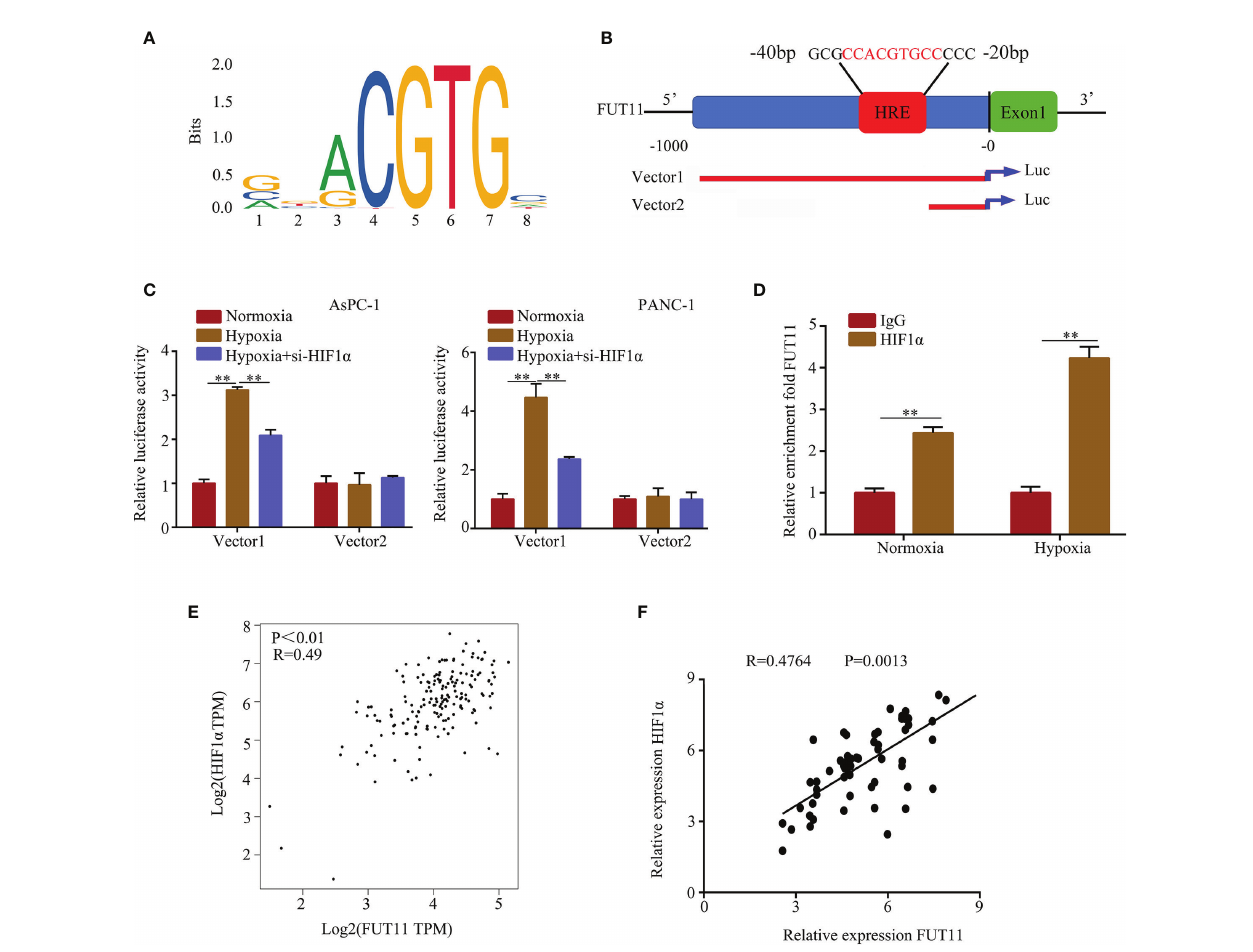
FIGURE 7 | HIF1 a regulates the expression of FUT11 by binding to the HRE of the FUT11 promoter. (A) The motif of HIF1 a . (B) The hypoxia response element (HRE) in the promoter of FUT11 (Vector 1: vector with full-length FUT11 promoter; Vector 2: vector with truncated FUT11 promoter which lack of HRE). (C) PANC ‐ 1 and AsPC-1 cells transfected with either a full ‐ length or truncated FUT11 promoter ‐ pGL3 reporter vector and cultured under hypoxia, with or without si ‐ HIF1 a . After 48 hours, luciferase activity was measured using the dual ‐ luciferase reporter assay system. (D) ChIP assays with anti-HIF1 a antibody verifying the binding between HIF1 a and hypoxia response element of the FUT11 promoter under normoxia and hypoxia. (E) Co-expression of FUT11 and HIF1 a based on the data from PC tissues via online database GEPIA. (F) Co-expression of FUT11 and HIF1 a based on the data from our clinical PC tissues (n=62). ** P <